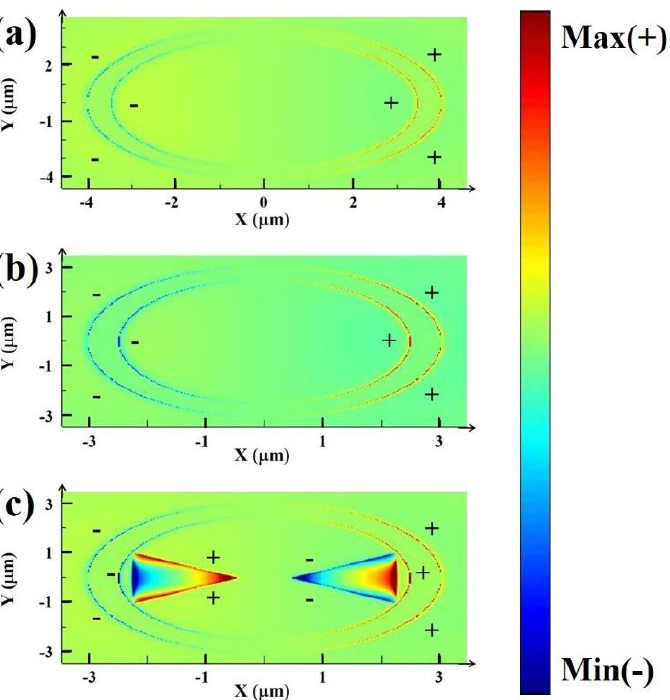
Figure 6. The simulated surface charge density distributions at the resonance peak with only the Au ring in the X–Y plane. ( a ) The inner and outer radius of the ring is set as to 3.5 μm and 4.0 μm. ( b ) The inner and outer radius of the ring is set as to 2.5 μm and 3.0 μm. ( c ) The simulated surface charge density distributions at the resonance with the proposed coupled structure in the X-Y plane. The inner and outer radius of the ring is set as to 2.5 μm and 3.0 μm. Please note that in the surface charge density distributions, the ring looks like an elliptical ring, which is caused by the difference in the step length of the X-axis and the Y-axis.